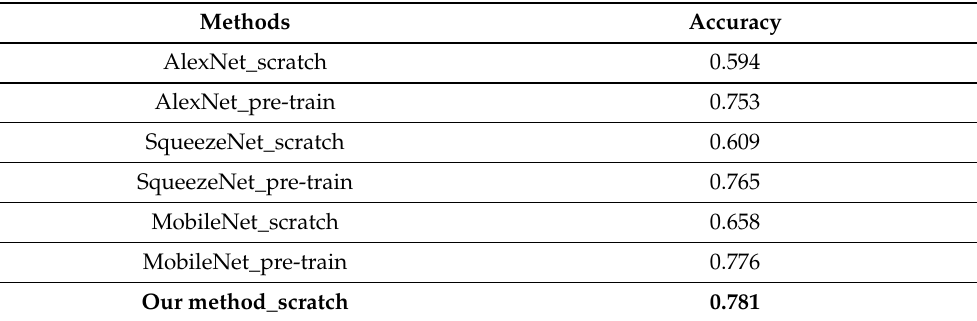
Table 7. Comparative experiment of different training methods. “_scratch” means training from scratch. “_pre-train” means using the ImageNet pre-training model for